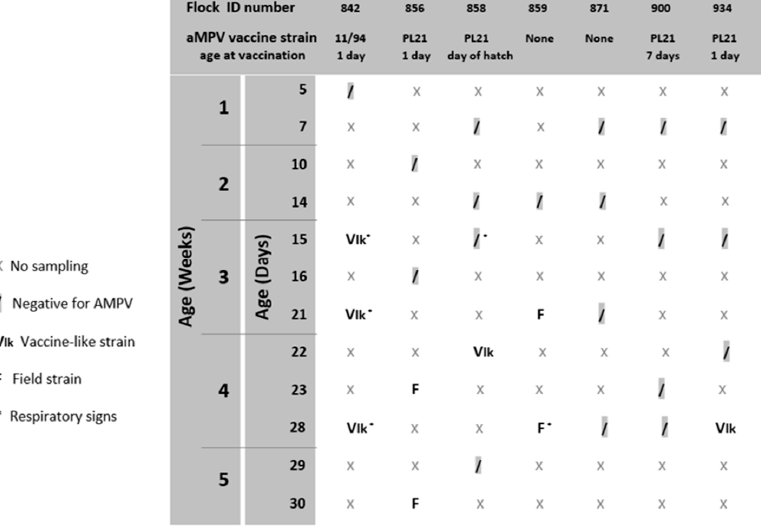
Figure 1. Results of aMPV diagnostic